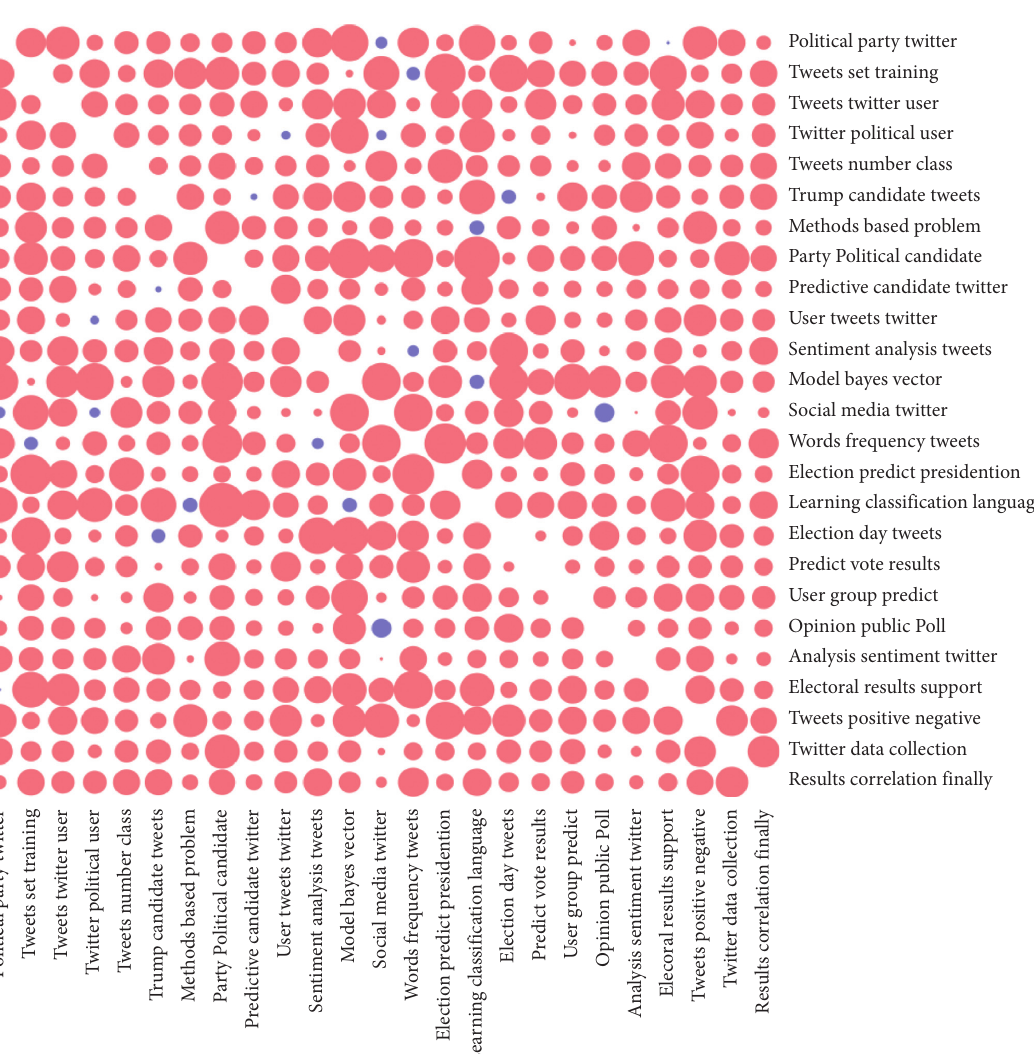
Figure 14: Topic correlation of the selected studies’